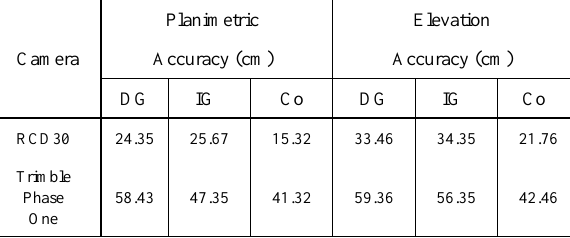
Table 4. ICP Level 1 (DG:Direct Georeferencing, IG:Indirect Georeferencing, Co:Combined DG-IG)